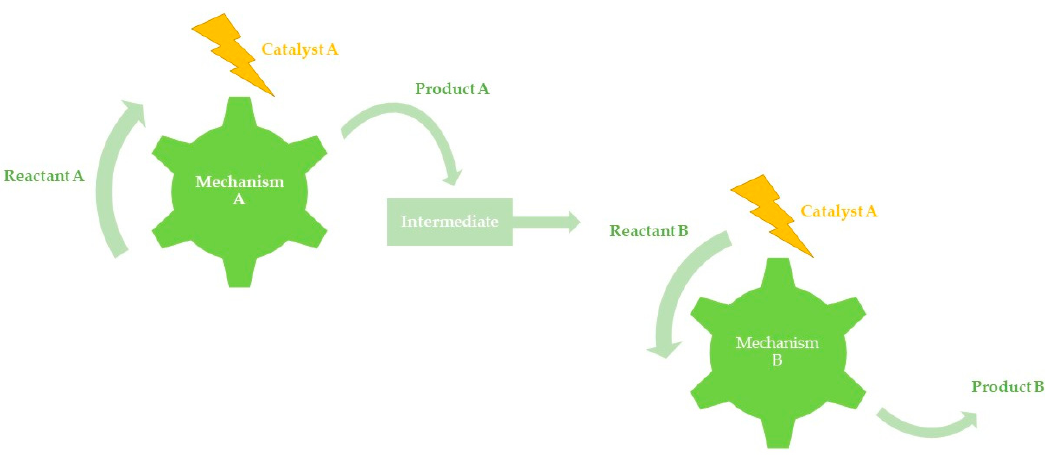
Figure 3. Schematic illustration of auto ‐ tandem catalysis.